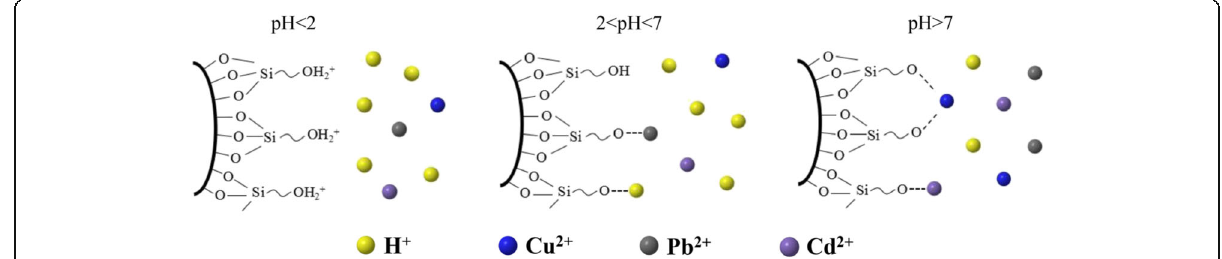
Fig. 5 Schematic diagrams of heavy metal adsorption mechanisms for mesoporous silica under different pH value conditions